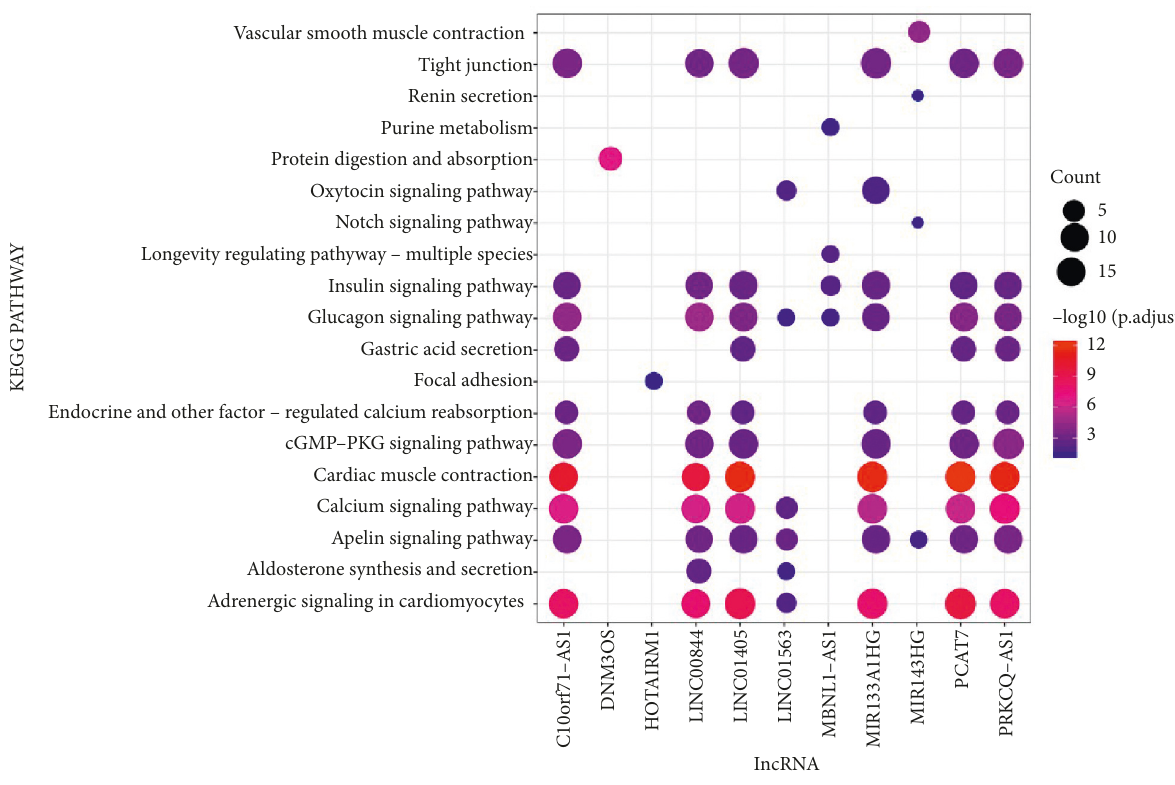
Figure 5: KEGG pathway analysis of lncRNA target genes.